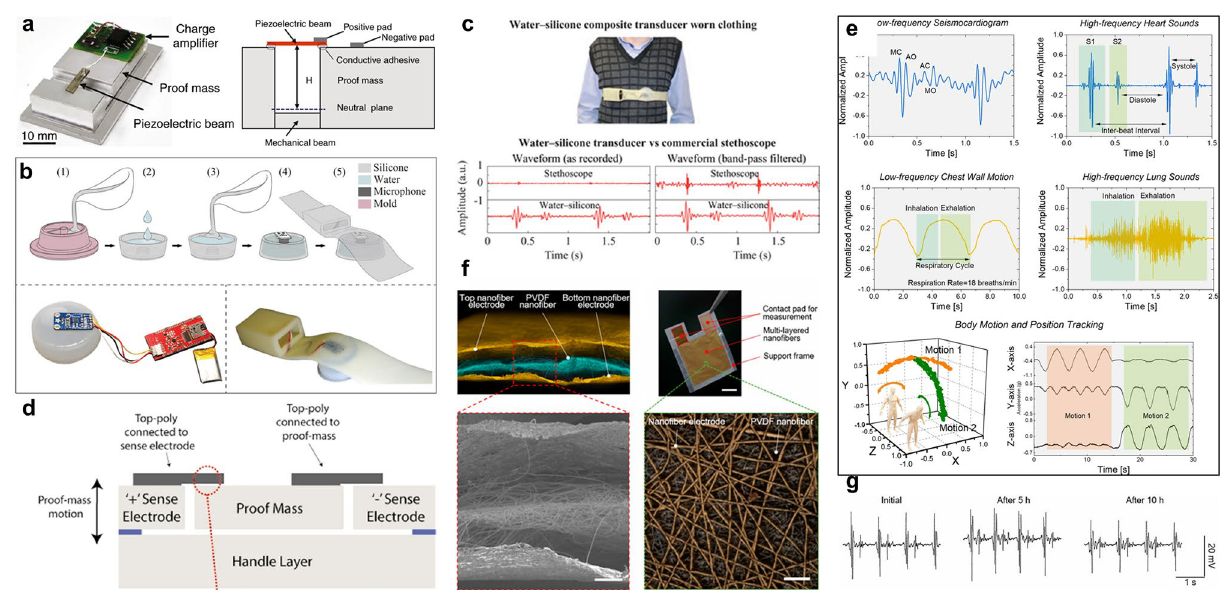
Fig. 13 Wearable heart sound sensor. a Inside view of the prototype with a printed circuit board and structure of the accelerometer-based on an asymmetric gapped cantilever structure. Reproduced with permission [273]. Copyright (2021), Nature Publishing Group. b Preparation of the water–silicone composite materials and integration with acoustic sensors. c Monitoring heart sounds while clothed and comparison of water–sil- icone based sensor and commercial stethoscope for heart sounds detecting. Reproduced with permission [274]. Copyright (2020), Wiley–VCH. d Cross-sectional view of the sensor showing the ultrathin capacitive gaps, satisfying low noise and broadband. e Recording of cardiopulmo- nary vibrations, sounds, and body motion. Reproduced with permission [276]. Copyright (2021), Nature Publishing Group. f Structure of all- nanofiber mechanoacoustic sensor. g Sensor allowing for more than 10 h of continuous monitoring. Reproduced with permission [277]. Copy- right (2020), National Academy of